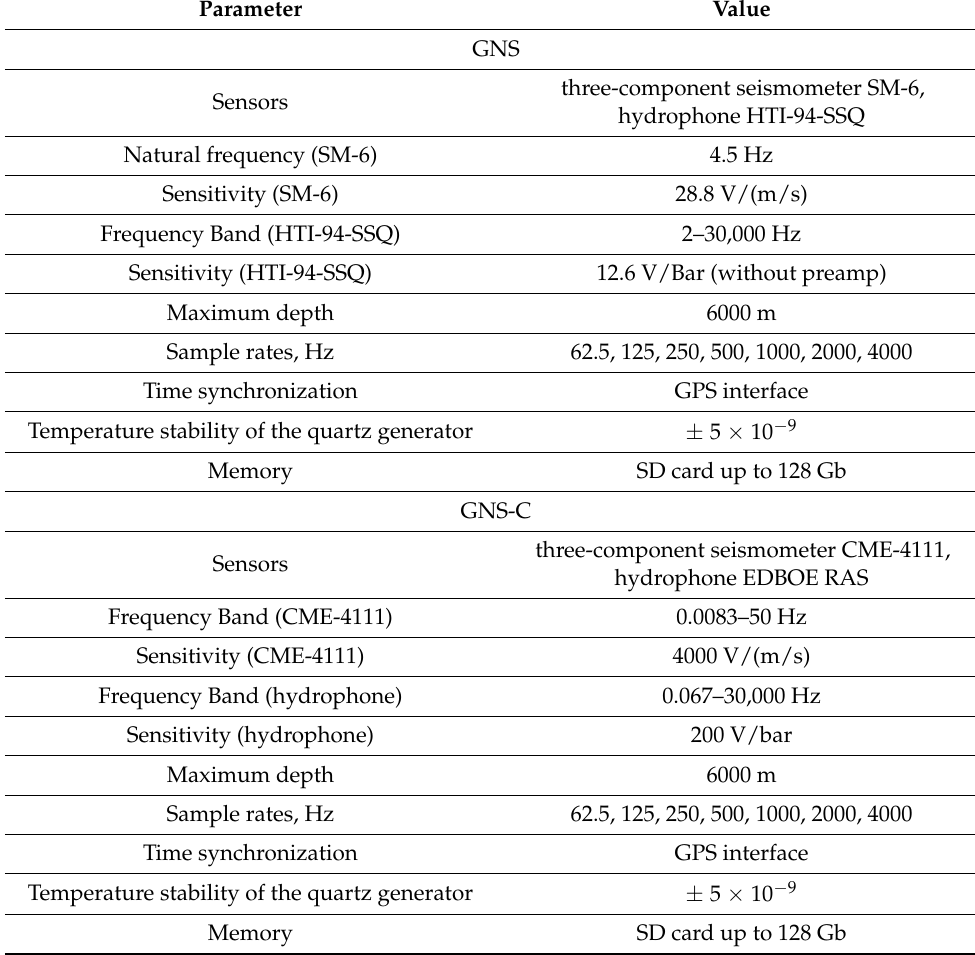
Table 6. Main technical characteristics of the self-popup